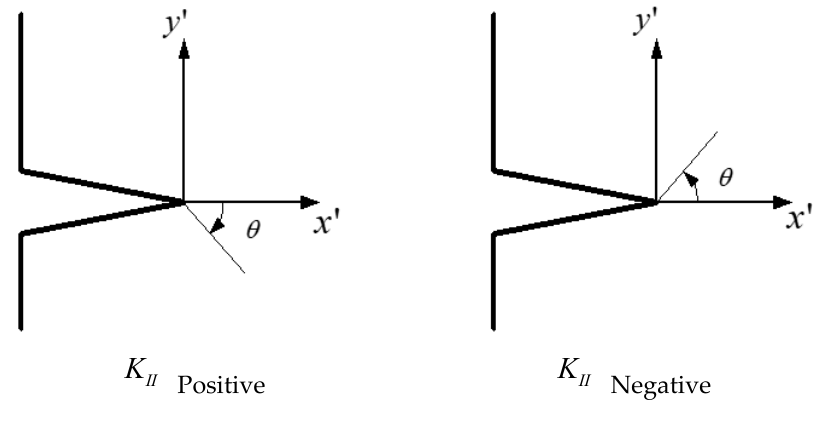
Figure 3. Sign of the crack growth angle.